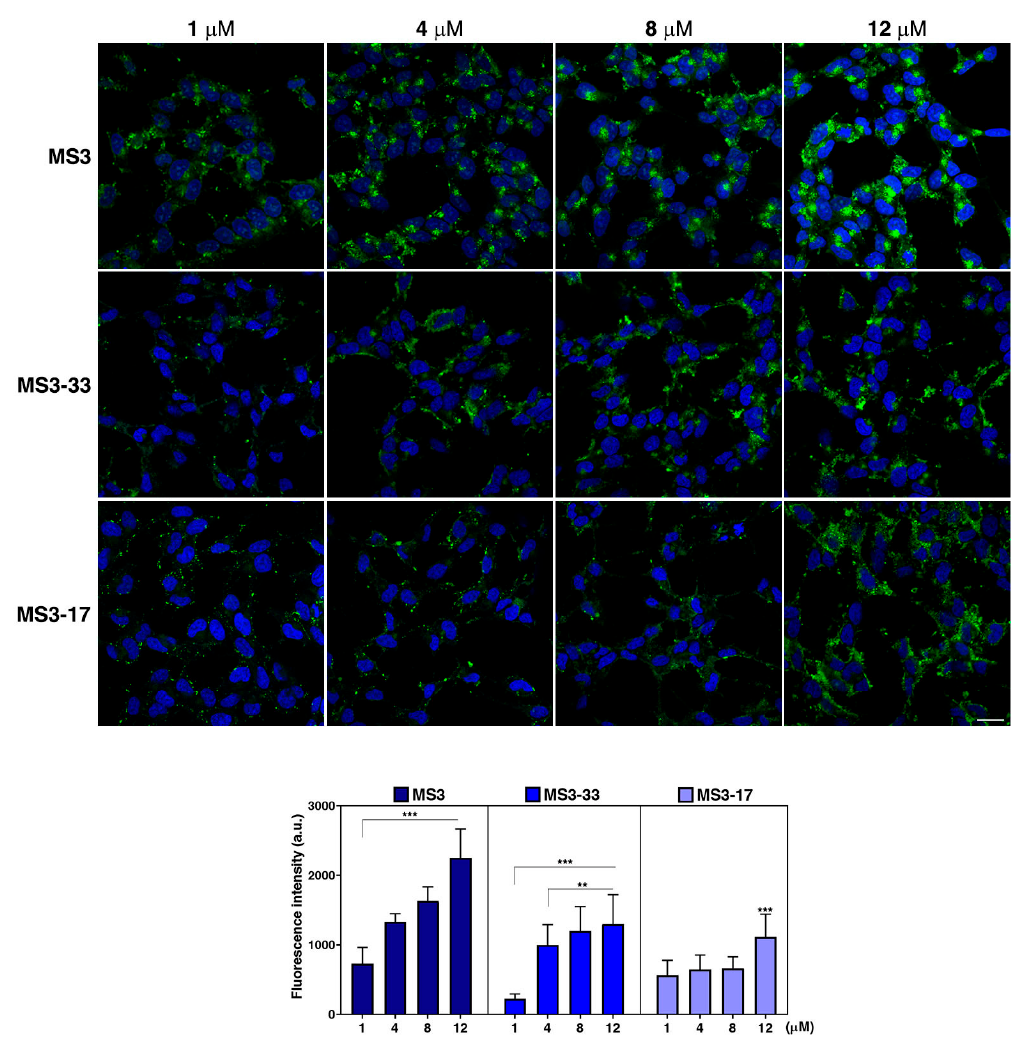
Figure 7. Uptake of FITC-conjugated MS3 and its truncated analogues in neuronal cells. SH-SY5Y cells were incubated with the three FITC-conjugated aptamers (green) for 24 h at different concentrations, as indicated. Then, cells were fixed, and nuclei were stained with DAPI (blue). Images were acquired with a confocal microscope. Scale bars, 6 μ M. Mean fluorescence intensity of three independent experiments is shown, n > 50 cells; error bars, mean ± SD. *** p < 0.001, ** p < 0.01, Bonferroni test after significant ANOVA.